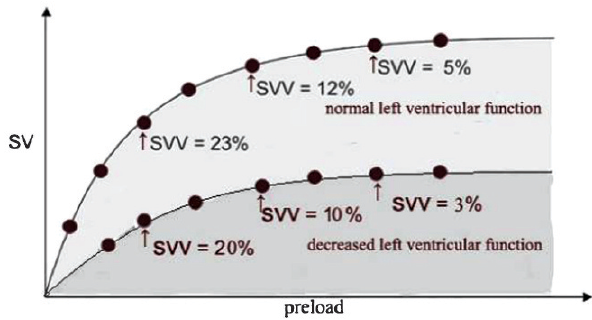
Figure 2 - SVV and Frank-Starling curve. The relationship between preload and SV in different left ventricular functions. Individual cardiac function could cause different cardiac reac- tions to a